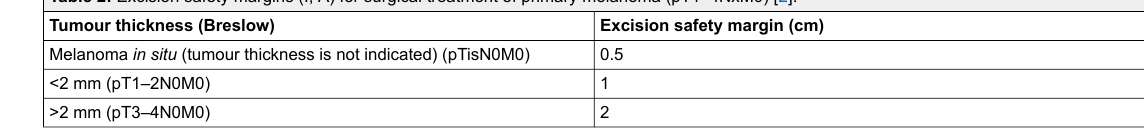
Table 2: Excision safety margins (I, A) for surgical treatment of primary melanoma (pT1–4NxM0) [2]. Tumour thickness (Breslow) Excision safety margin (cm) Melanoma in situ (tumour thickness is not indicated)